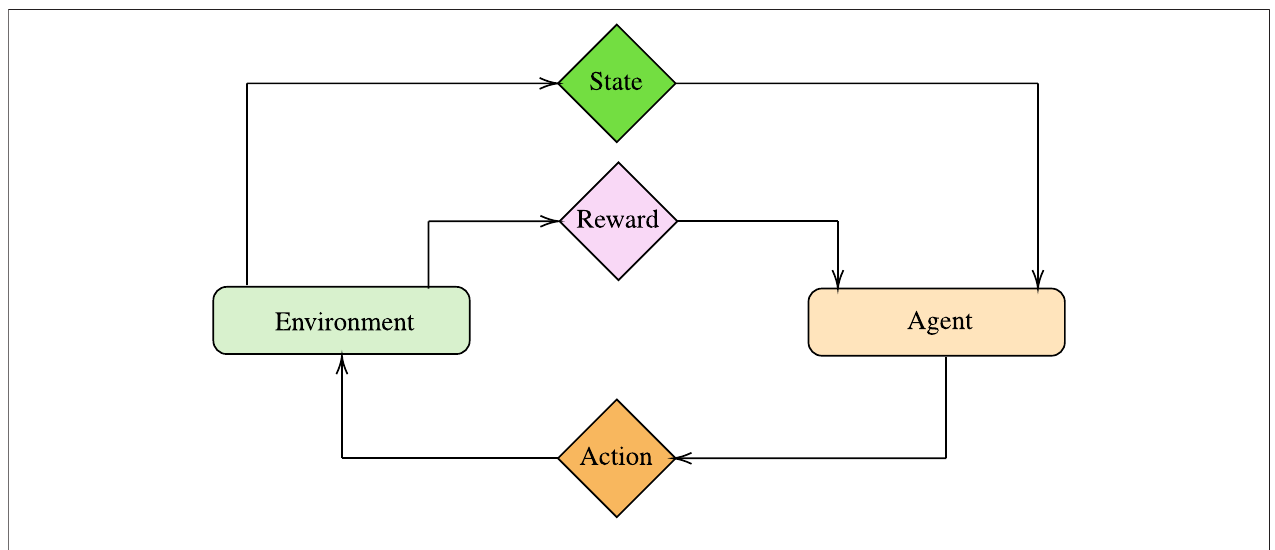
FIGURE 13 | Reinforcement learning